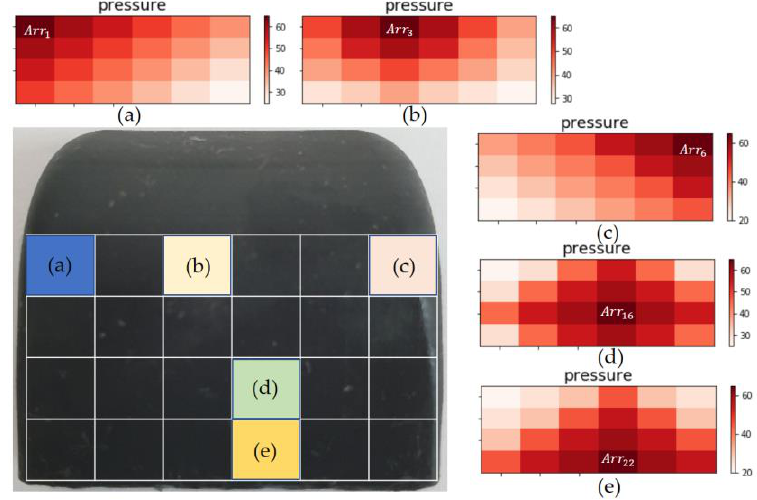
Figure 11. Sensing expression according to touch point of tactile sensing module.